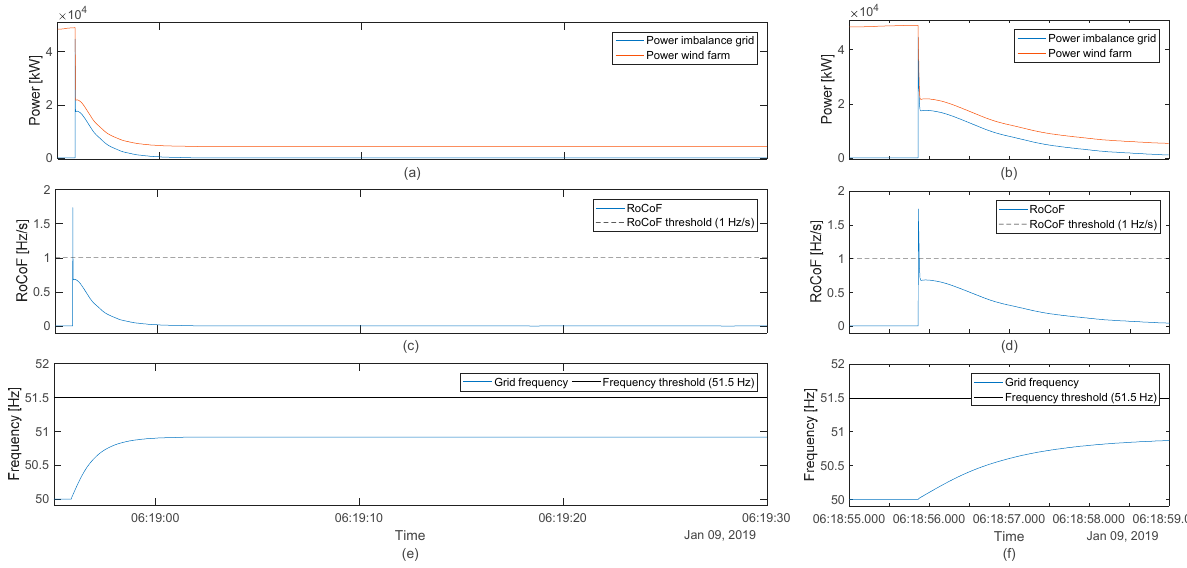
Figure 11. Results of scenario II: power imbalance in the islanded grid and power of the simulated wind farm for ( a ) the full simulation time and ( b ) a zoom to the time of the event; ( c )/( d ) RoCoF and RoCoF threshold; ( e )/( f ) grid frequency and frequency threshold. Time axes of ( e ) and ( f ) are valid for the above subplots as well.